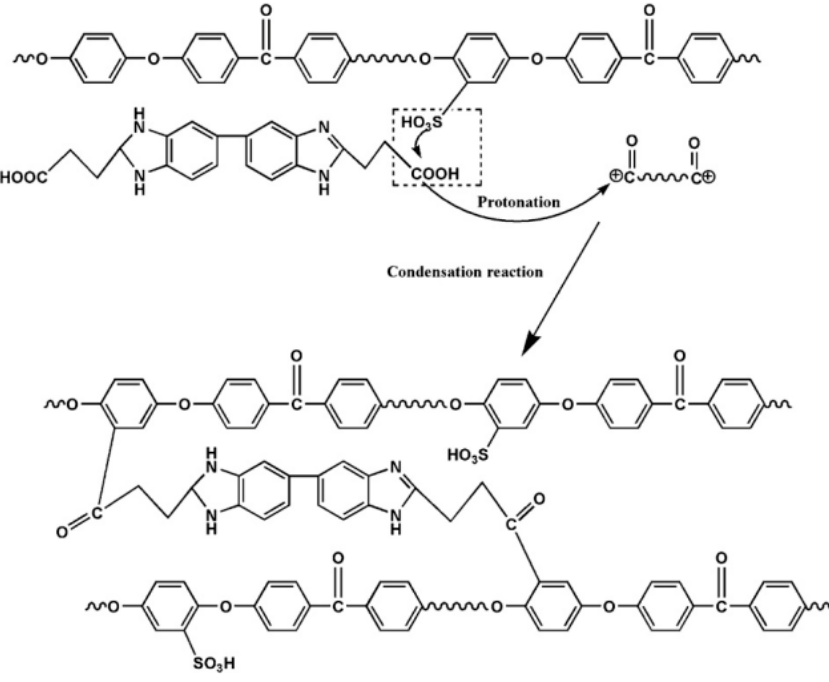
Figure 12. Cross-linked SPEEK membrane by benzimidazole